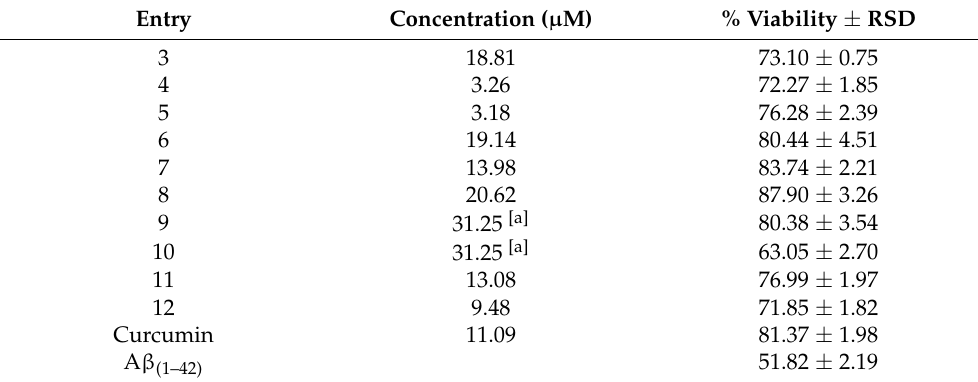
Table 3. Neuroprotective effect on SK-N-SH neuroblastoma cells of test compounds at the IC 50 value, except compounds 9 and 10 , against A β induced damage.